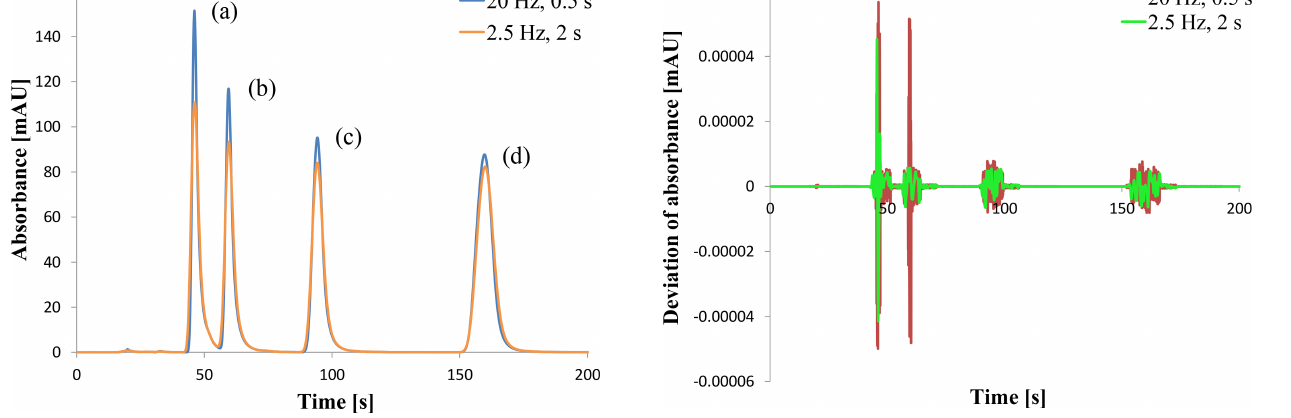
Figure 3. Chromatogram of dimethyl phthalate (a), diethyl phtha- late (b), biphenyl (c) and o-terphenyl (d) using a sampling rate of 20Hz and a response time (signal filtration) of 0.5s or 2.5Hz and a response time of 2s.